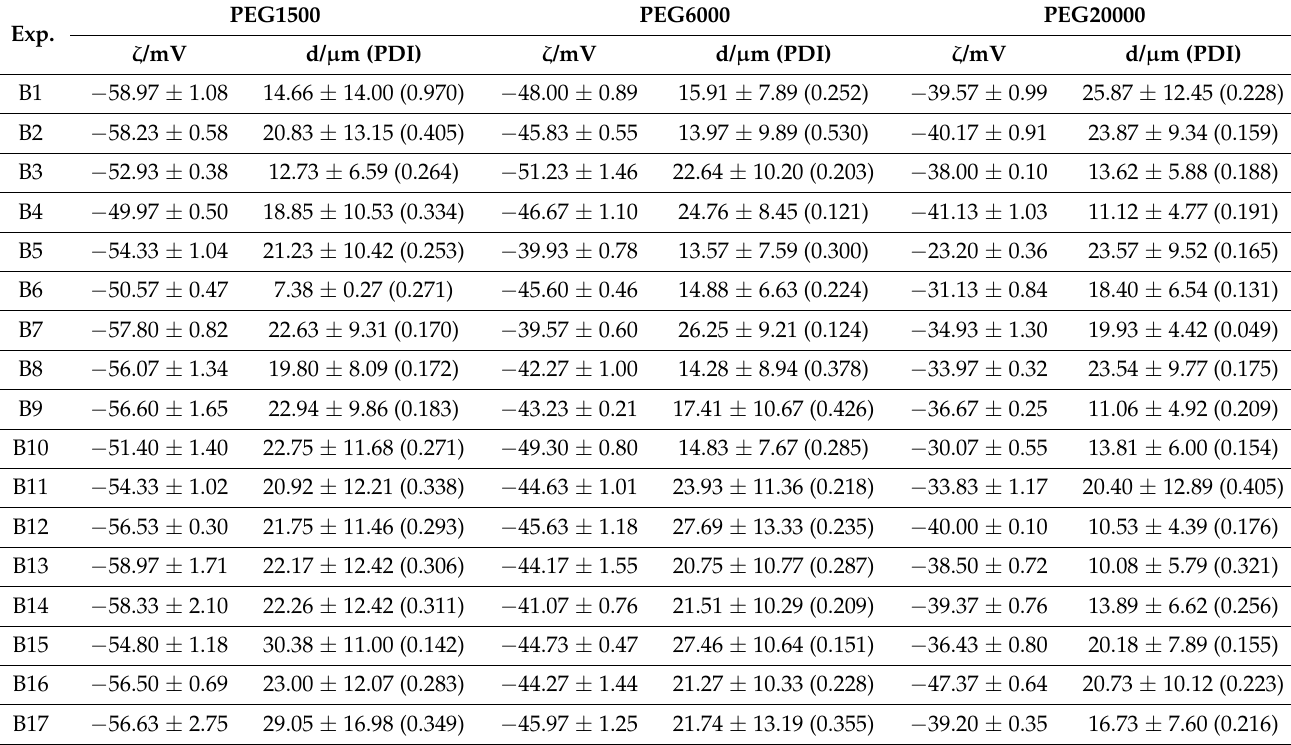
Table 3. Mean values of zeta potential and the average Feret diameter ( n = 3) of the oil-in-water emulsion droplets prepared in a high shear batch system using three different emulsifiers (PEG1500, PEG6000 and PEG20000). Polydispersity index (PDI) for the given droplet diameter is listed in the